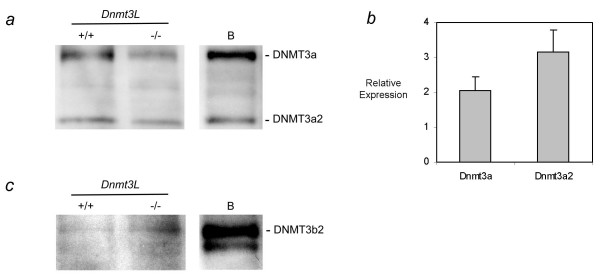
Protein and transcript variant analysis of Dnmt3a and Dnmt3b in DNMT3L wild type and depleted 15 dpp oocytes. Western Blot analysis of a) DNMT3A and c) DNMT3B was carried out on growing oocytes isolated from Dnmt3L wild-type and homozygous 15 dpp females (280 oocytes/lane). For comparison and isoform identification, the panels on the right labelled 'B' show blotting results for type B spermatogonia (for the loading control see Additional file 4). As suggested by the RNA expression analysis in (b), both DNMT3a and DNMT3a2 are present in growing oocytes and the ratio of these transcripts does not change significantly in Dnmt3L homozygous oocytes. DNMT3b2 is the more abundant isoform in wild-type Dnmt3L oocytes and appears to be upregulated in mutant oocytes as also suggested by the RNA expression data in Figure 4a. b) Relative expression of Dnmt3a and Dnmt3a2 was determined using transcript specific primers. Expression was normalized to 18S. As previously mentioned, both transcripts are expressed in growing oocytes.